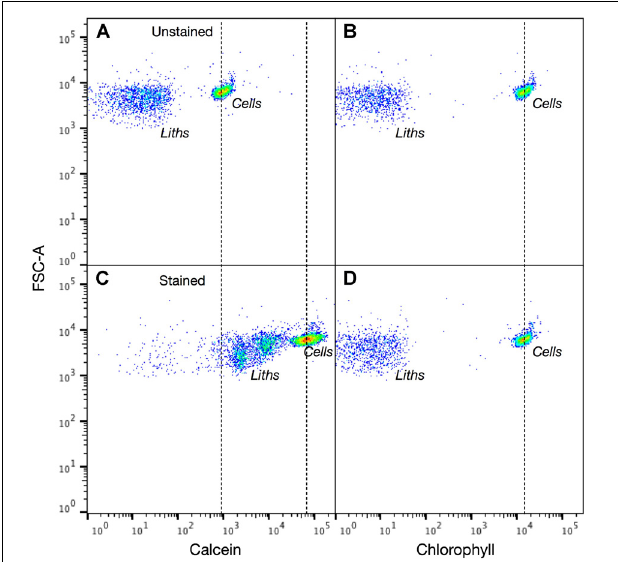
FIGURE 9 | Calcein labeled and unlabeled Coccolithus braarudii cells are readily detected using flow cytometry. Intensity dot plots of (A) calcein and (B) chlorophyll signals vs. forward scatter (FSC-A) for unstained C. braarudii cells. (C,D) Intensity dot plots of calcein and chlorophyll channels for cells after 2 h staining with calcein. Both cells and detached coccoliths are readily identified in each channel. For chlorophyll there is no change in the distribution of unstained and stained cells or coccoliths (dotted line for reference). The stained and unstained populations of cells and coccoliths are clearly distinguished in the calcein channel (dotted lines for reference). 5,000 events